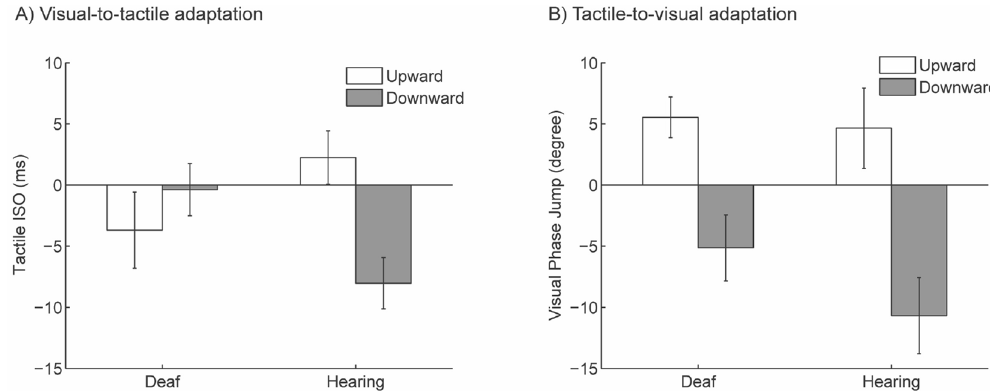
Figure 4. Cross-modal aftereffects measured by PSE in Experiment 1. (Panel A ) shows the average of tactile PSEs after adaptation to visual motions, while (Panel B ) shows the average of visual PSEs after adaptation to tactile motions. PSE after the upward and downward adaptation are shown respectively in white and grey. Error bars represent one standard